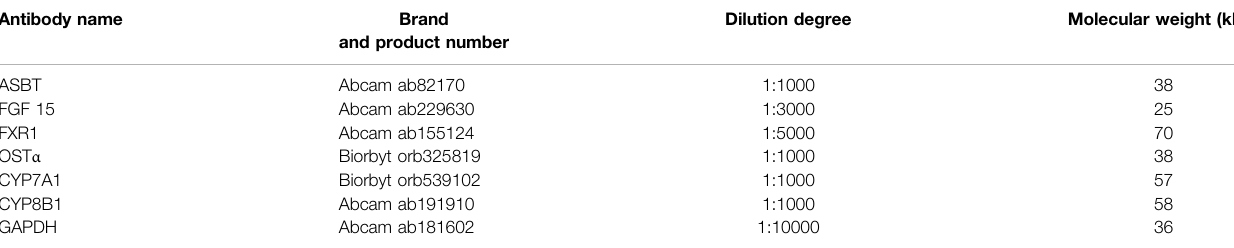
TABLE 1 | Primary antibody information in Western Blotting